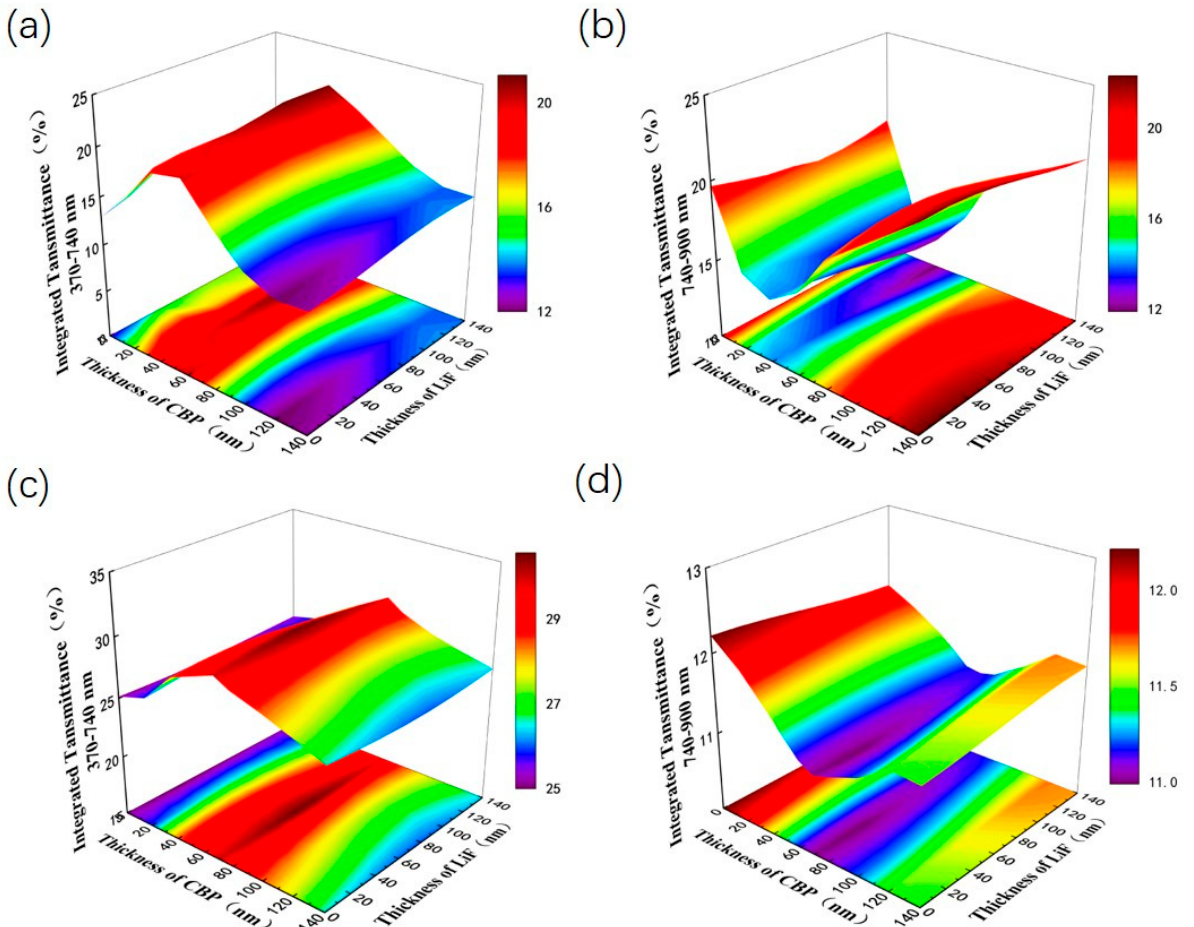
Figure 5. The e ff ects of CBP layer thickness and LiF layer thickness in OCL on the simulated trans- Figure 5. The effects of CBP layer thickness and LiF layer thickness in OCL on the simulated mi tt ance of ST-OSCs in di ff erent wavelength ranges. Double-layers OCL ( a ) 370–740 nm, ( b ) 740– transmittance of ST-OSCs in different wavelength ranges. Double-layers OCL ( a ) 370–740 nm, 900 nm; Four-layers OCL ( c ) 370–740 nm, ( d ) 740–900 nm. ( a ) 370–740 nm, ( b ) 740–900 nm; Four- ( b ) 740–900 nm; Four-layers OCL ( c ) 370–740 nm, ( d ) 740–900 layers OCL ( c ) 370–740 nm, ( d ) 740–900 nm.